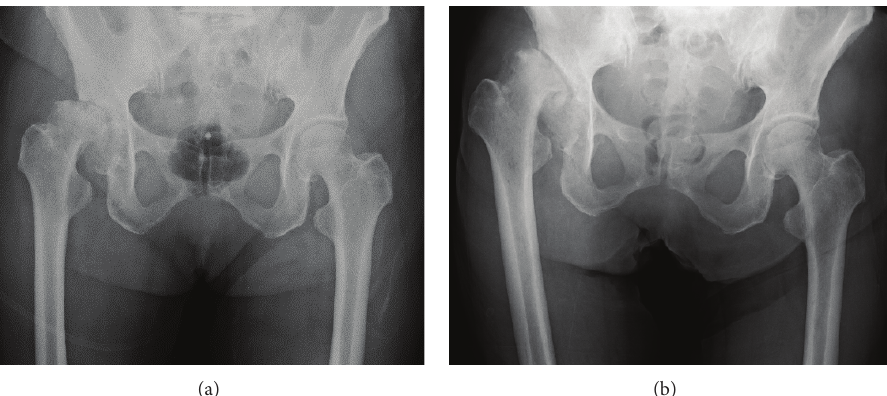
Figure 1: (a) A radiograph 2 months before admission to our hospital. (b) A radiograph 1 month after admission to our hospital. (a) and (b) show rapid hip joint destruction.